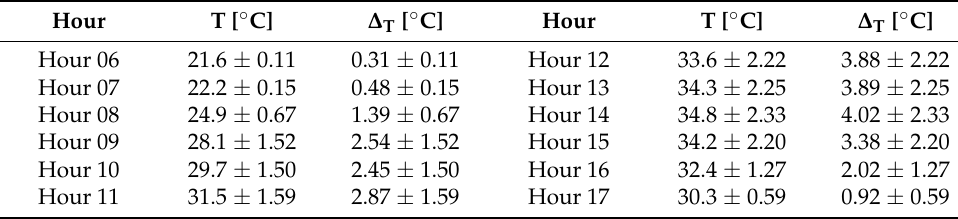
Table 5. Numerical parameters obtained for temperature